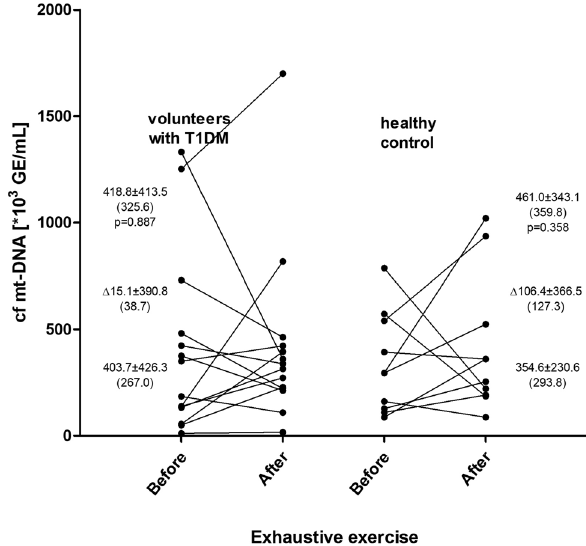
Figure 2. Circulating cell free mitochondrial DNA (cf mt-DNA) before and after exhaustive treadmill exercise at speed corresponding to 70% of personal VO2max in male volunteers with T1DM (n = 14) and healthy control group (n = 11). Δ exercise induced increment. Results are expressed as mean, standard deviation, and (median). No significant differences were found within and between groups. The points (corresponding to values before and after the exercise) joined with lines represent individual results in both studied